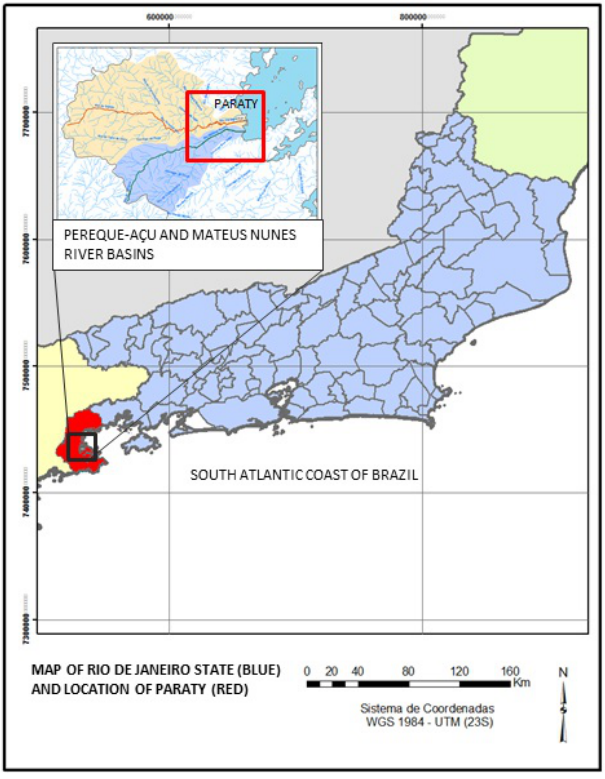
Fig. 1 . Location of the Pereque-Açu and Mateus Nunes river basins in the Rio de Janeiro